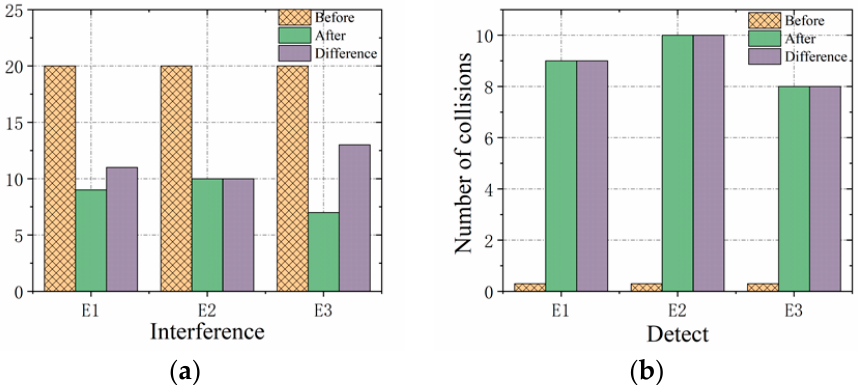
Figure 14. Comparison of the effect before and after multi-agent learning: ( a ) comparison of the effect before and after learning for the red interference multi-agent (orange represents the number of collisions before training, green represents the number of collisions after training, and purple represents the difference between the number of collisions before and after training); ( b ) comparison of the effect before and after learning for the blue detection multi-agent (orange represents the number of collisions before training, green represents the number of collisions after training, and purple represents the difference between the number of collisions before and after training).